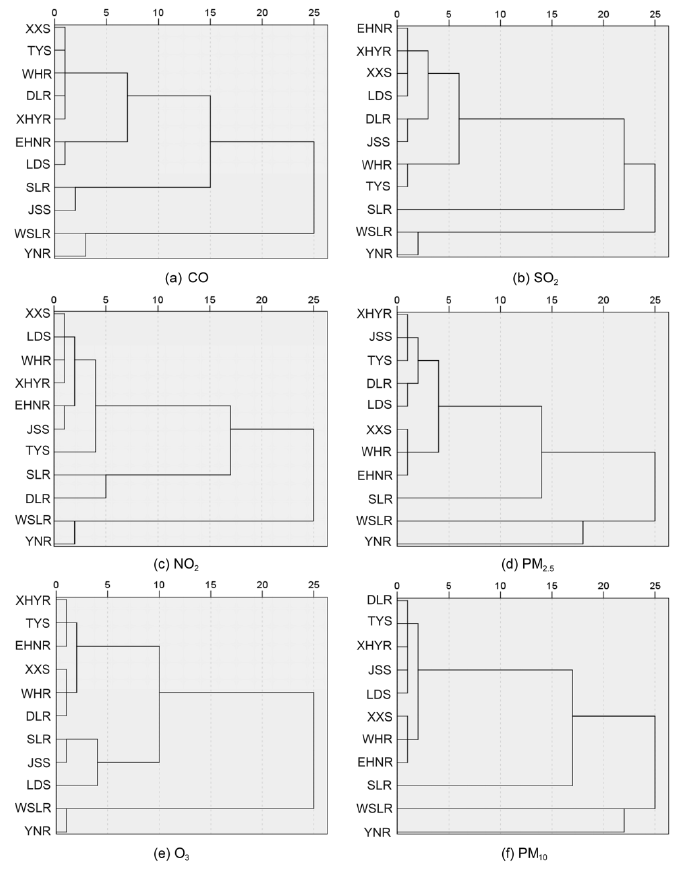
Figure 3. Cluster analysis of 11 monitoring stations based on pollutant concentrations: ( a ) CO, ( b ) SO 2 , ( c ) NO 2 , ( d ) PM 2.5 , ( e ) O 3 , ( f ) PM 10 .